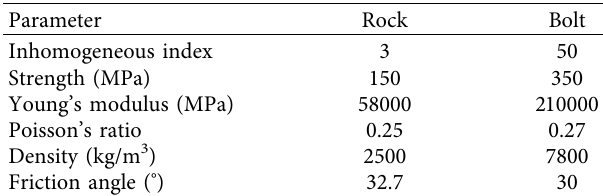
Figure 1: Numerical calculation model with a square underground chamber and loading method. The three points A1, A2, and A3 are located at the top, middle, and bottom of the bolt, respectively, p S stands for the static load, and p d is the meaning of dynamic load. Table 1: Numerical model physical and mechanical